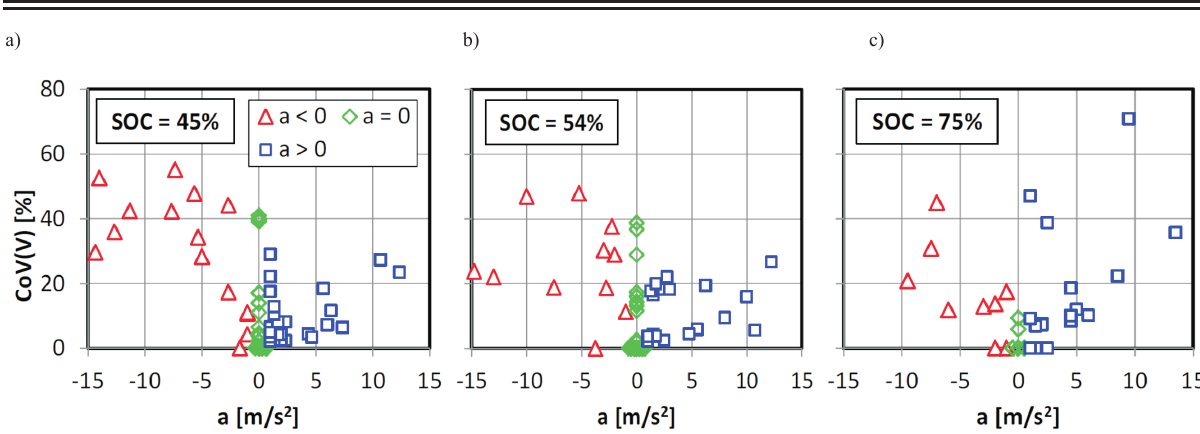
Fig. 11. The instantaneous values of vehicle speeds distribution with division into a braking phase, constant speed phase and acceleration phase in relation to the battery charge level: a) 45%, b) approx. 54%, c) 75%